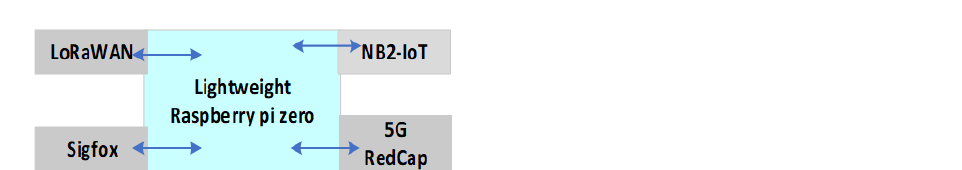
Figure 1. LHM-N Network Architecture.